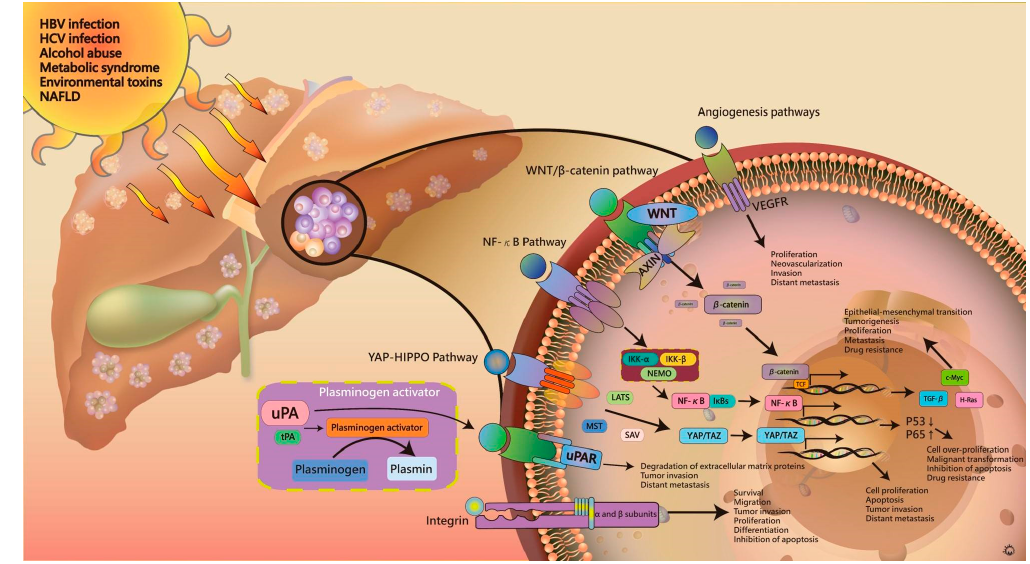
Figure 2. Detailed mechanisms in hepatocarcinogenesis. The exposure to hepatotoxic agents triggers gene mutation and local inflammation via Wnt/ β -catenin, NF- κ B, signaling, the YAP-HIPPO pathway, and angiogenesis pathways. PA and integrin are also involved in the carcinogenesis process.